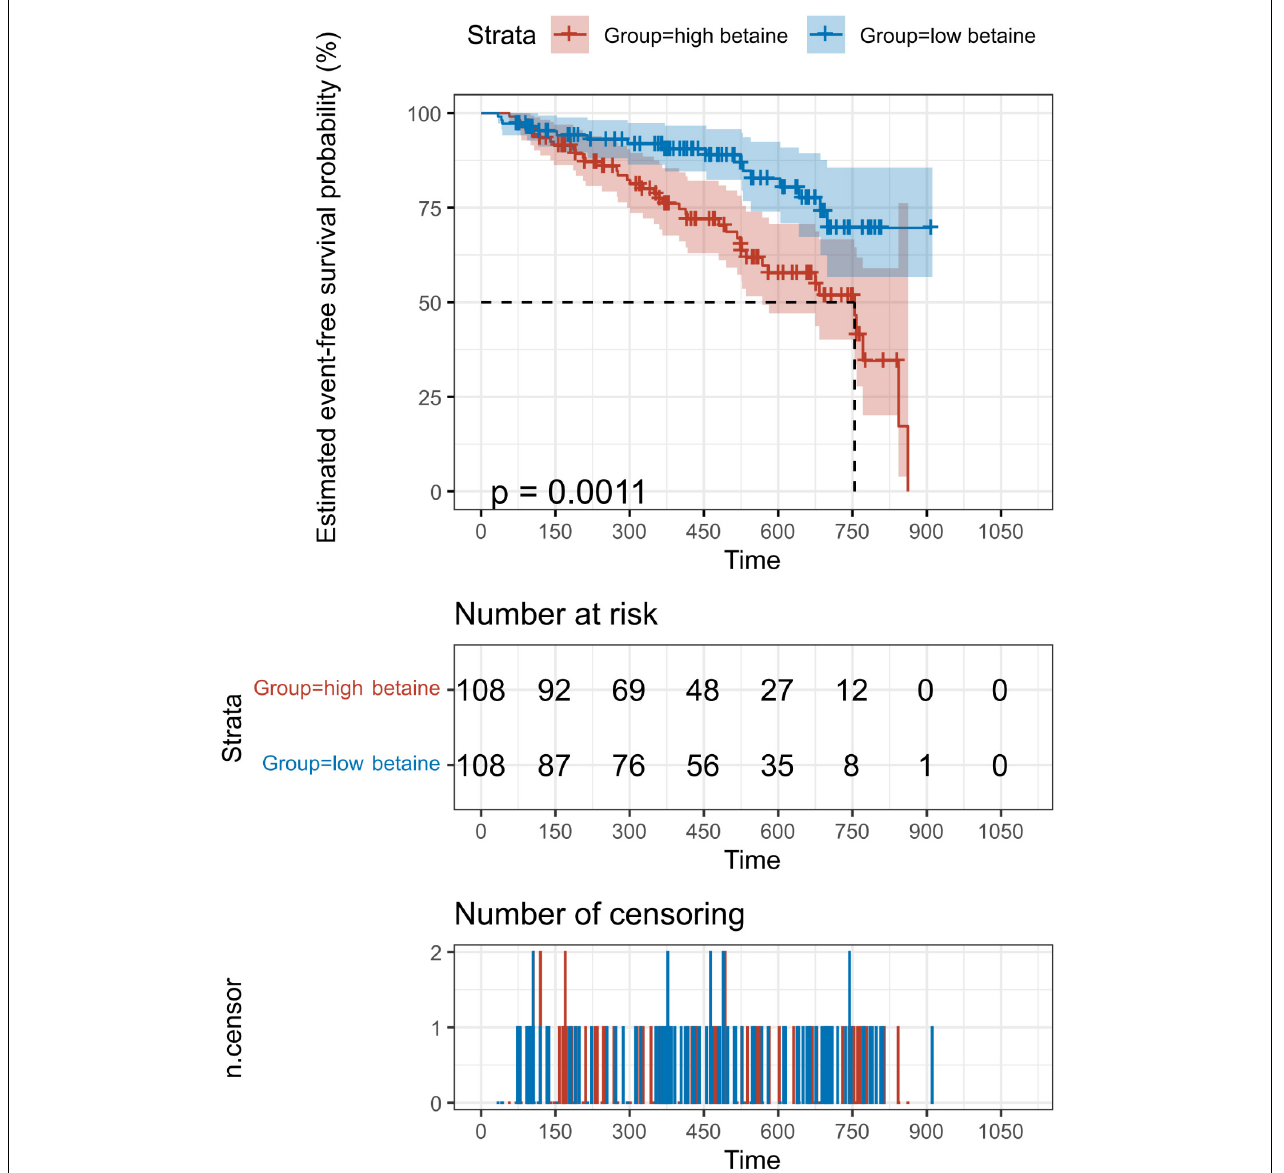
FIGURE 2 | Kaplan–Meier (KM) analysis for the incidence of composite outcome events. Patients were divided into two groups according to the 50th percentile of plasma betaine concentrations (49.8 µ M) at baseline. A total of 216 patients with PH were included for exploration. Value of p calculated by the log-rank